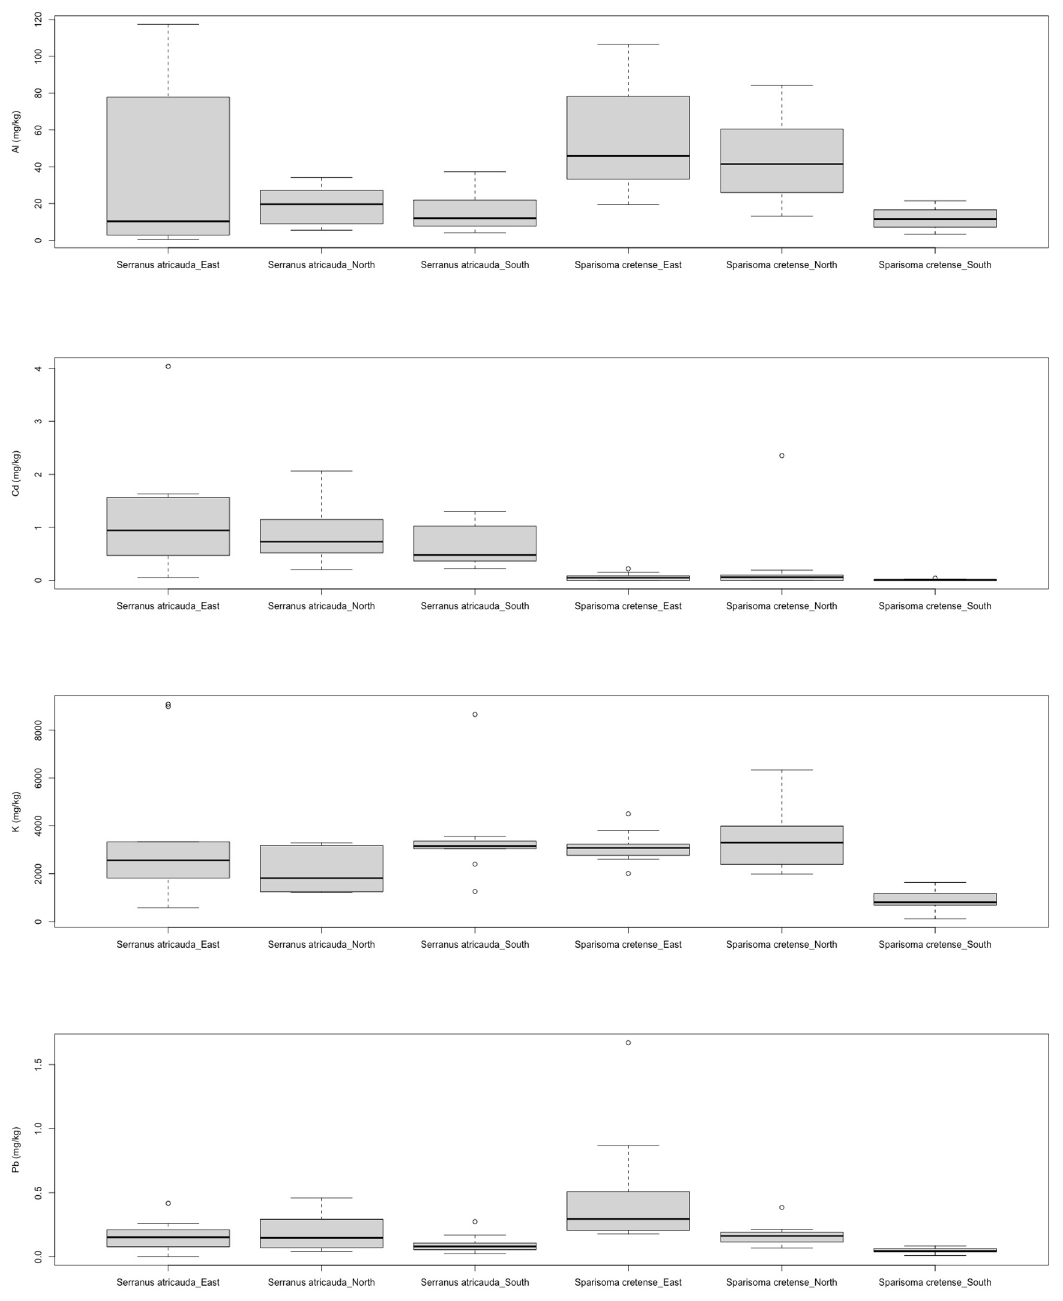
Figure 3. Boxplot of the two species in each sampling area for Al, Cd, K and Pb. Table 6. Results of the two-way PERMANOVA analyzing the variation in the content of heavy metals and trace elements in liver tissue in species according to study zone, considering the level of the factor “Species”.